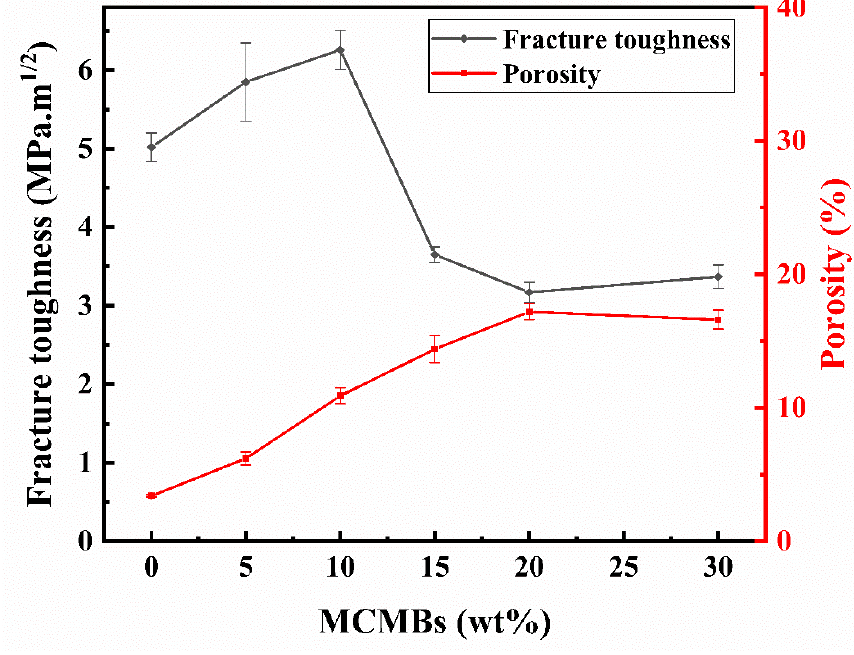
Figure 5. Fracture toughness and porosity fluctuate with MCMB content.